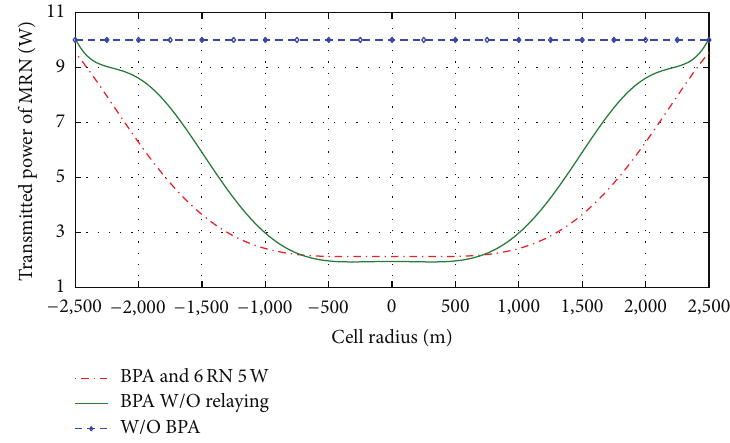
Figure 9: Reducing power consumption by using BPA.